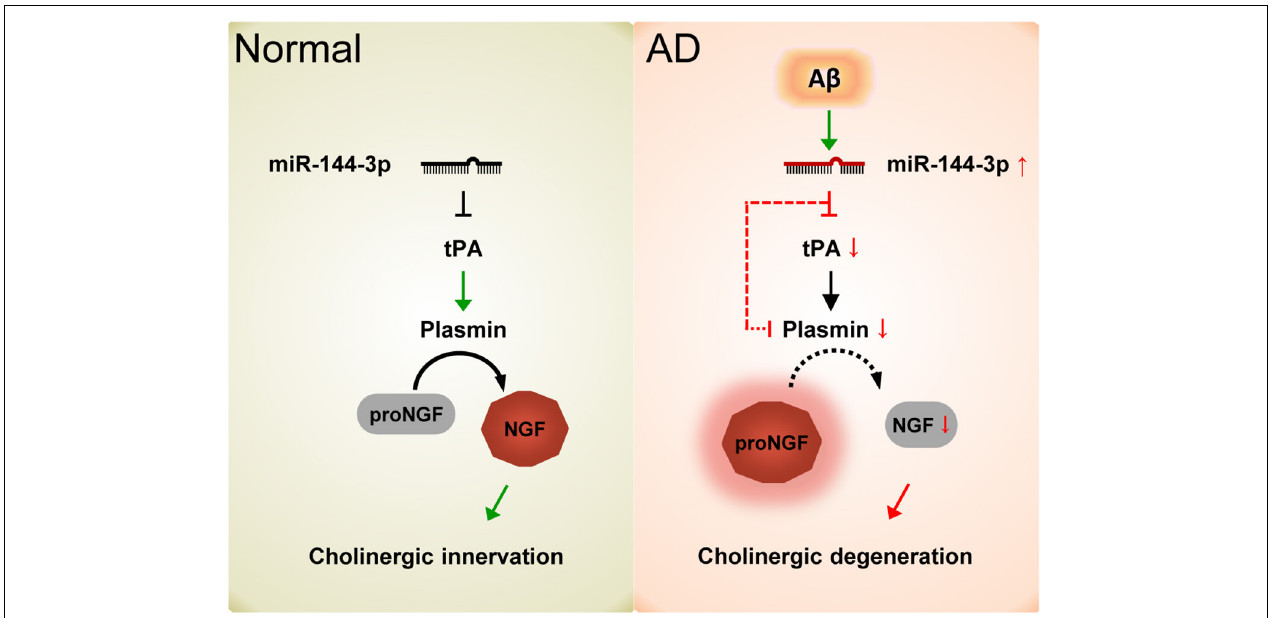
FIGURE 7 | Schematic diagram of the current study. In normal conditions, the proper levels of tPA and plasmin play an important role in the maturation of NGF and maintain the function of the cholinergic system. In AD, the elevation of miR-144-3p leads to the downregulation of tPA and plasmin, which in turn inhibits the maturation of NGF and impairs the plasticity of cholinergic